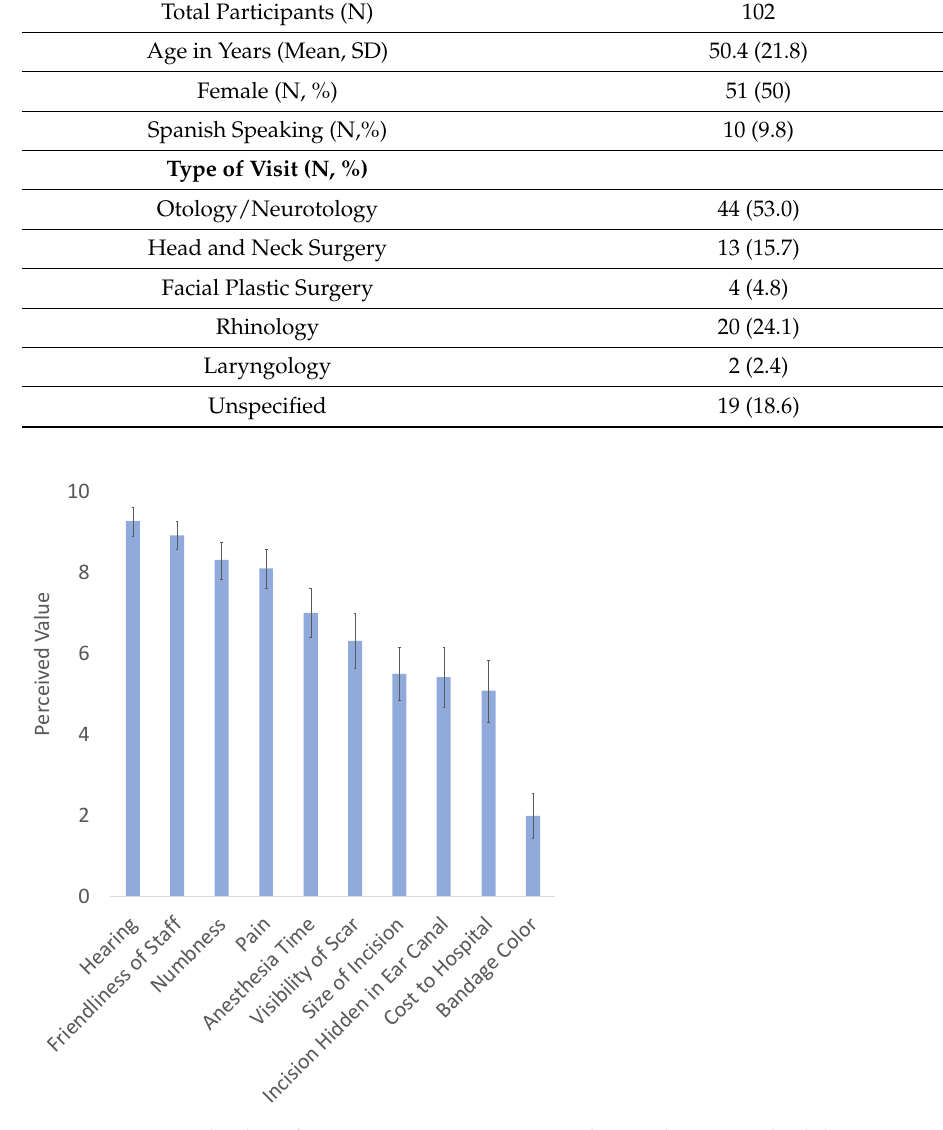
Figure 1. Perceived value of ear surgery outcomes. Error bars indicate standard deviation.